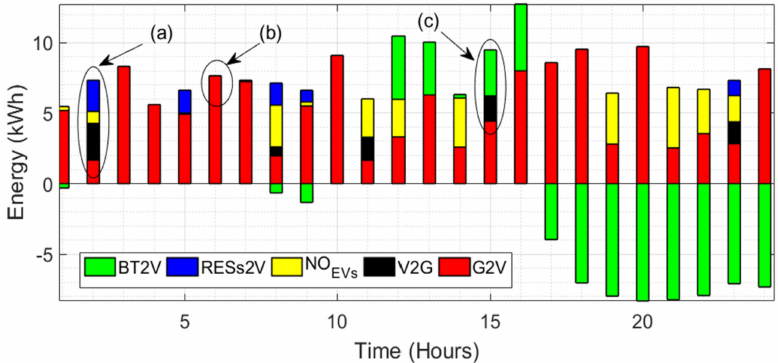
Figure 12. SMCM analysis result for the scenarios (RESs2V, No EV, G2V, V2G, BT2V).